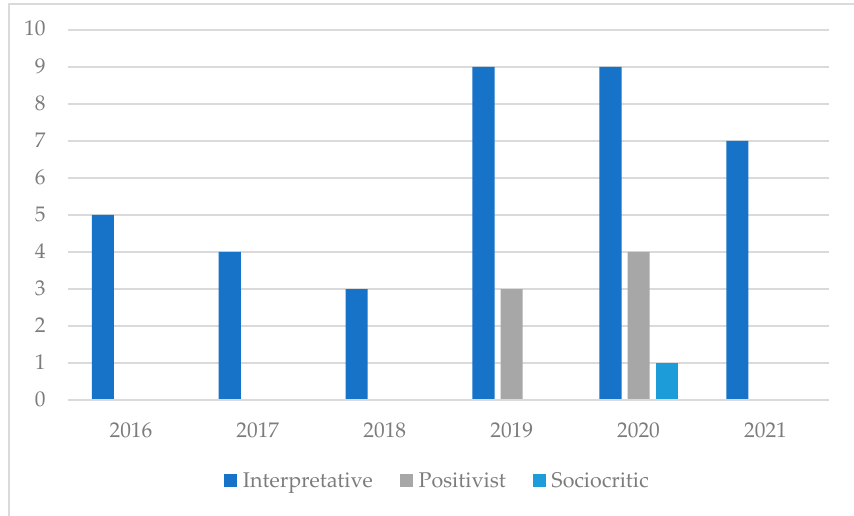
Figure 4. Research paradigm by publication date.